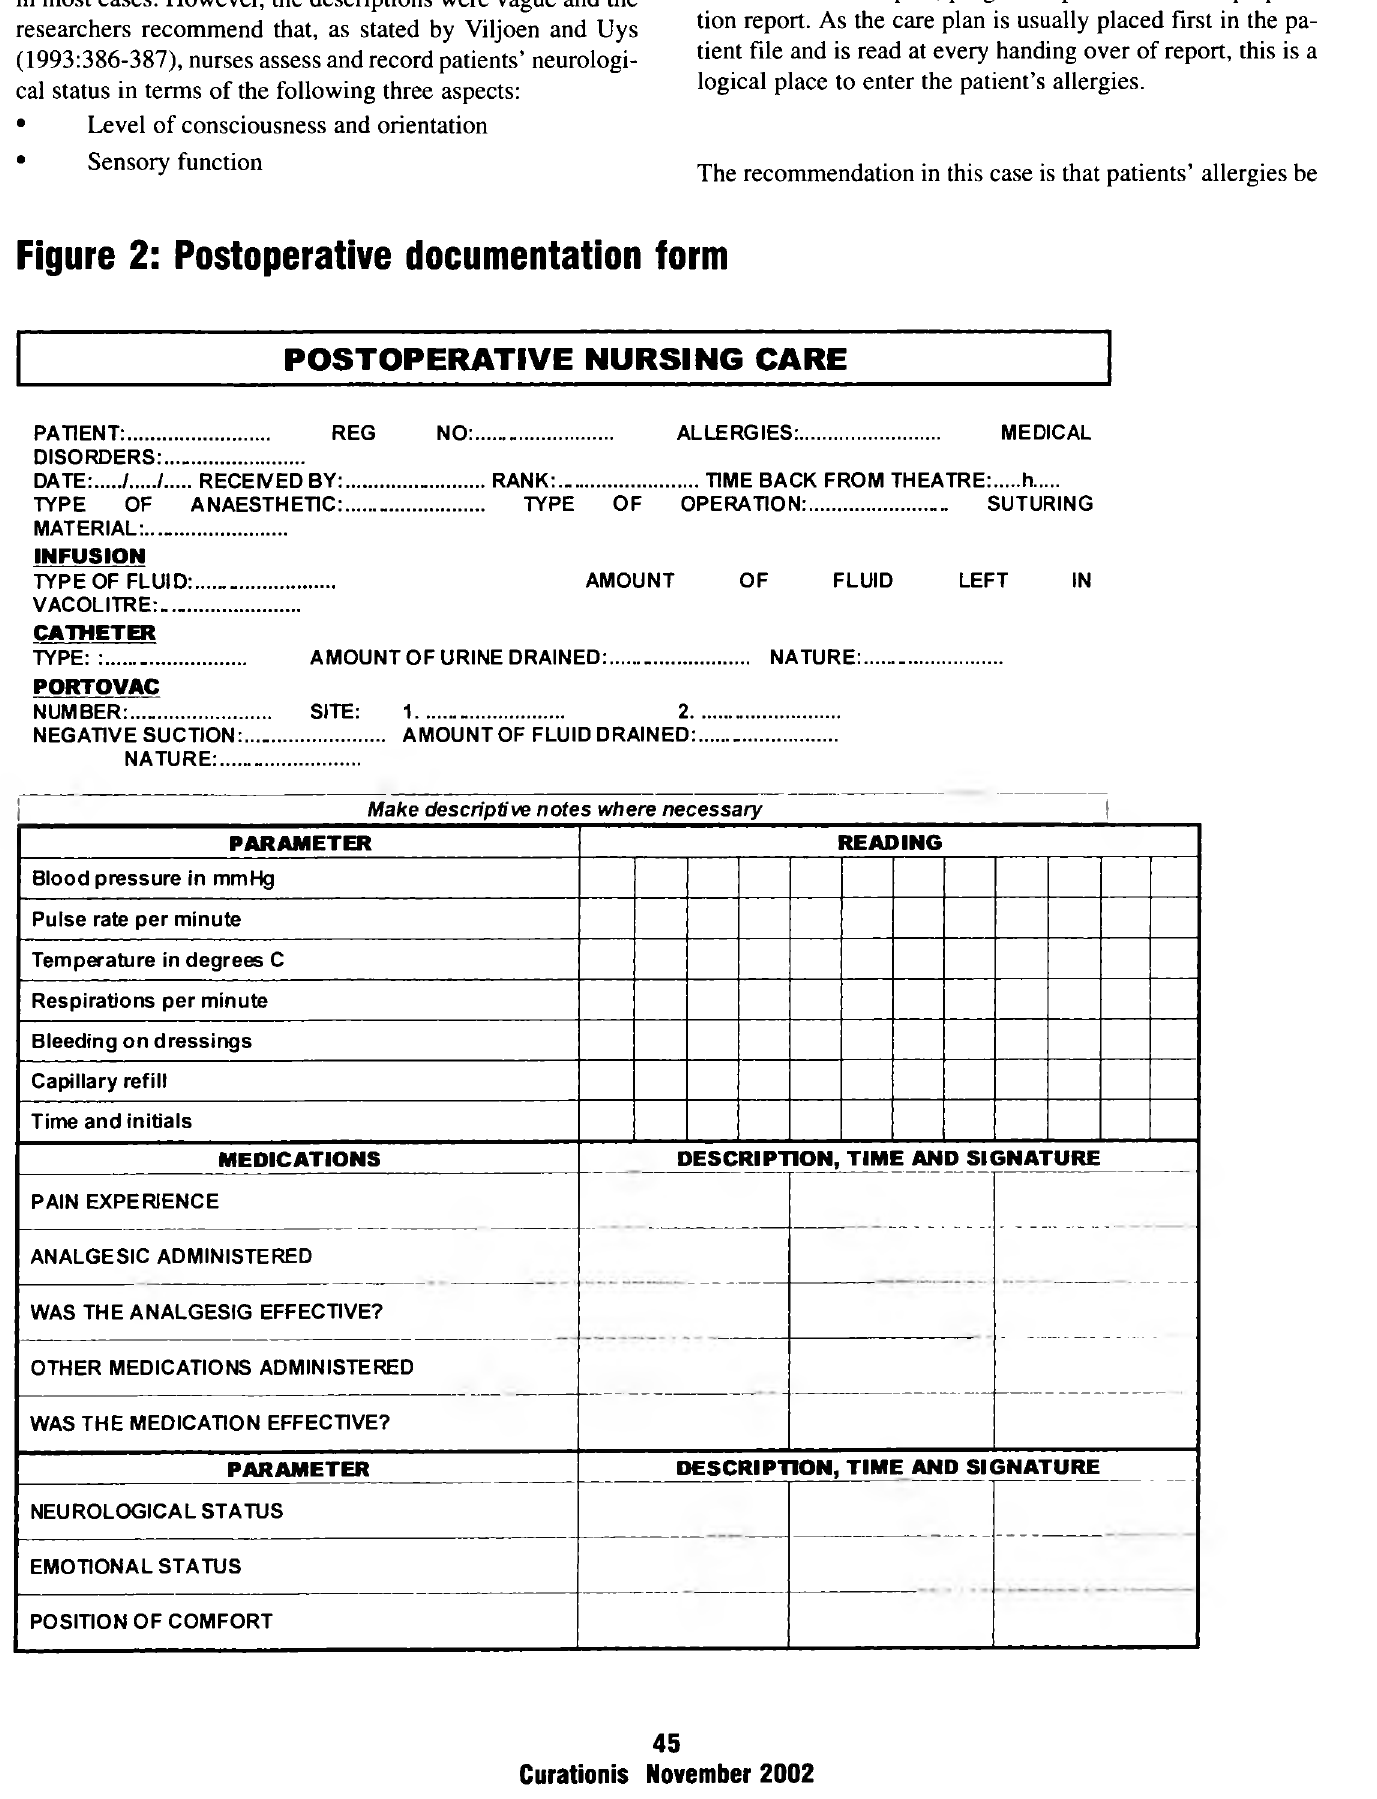
Figure 2 : Postoperative documentation form PO STO PERATIVE NU R SIN G